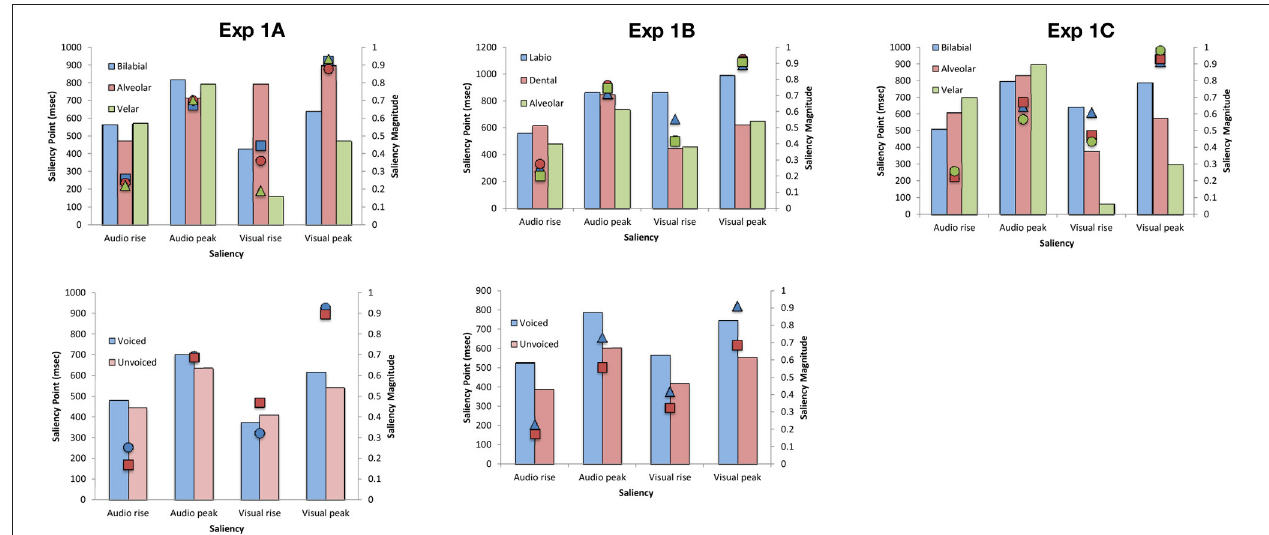
FIGURE 5 | Average saliency rise and peak (in ms) and saliency magnitude for each point for the audiovisual speech stimuli used in Experiments 1A–C as a function of the place of articulation and